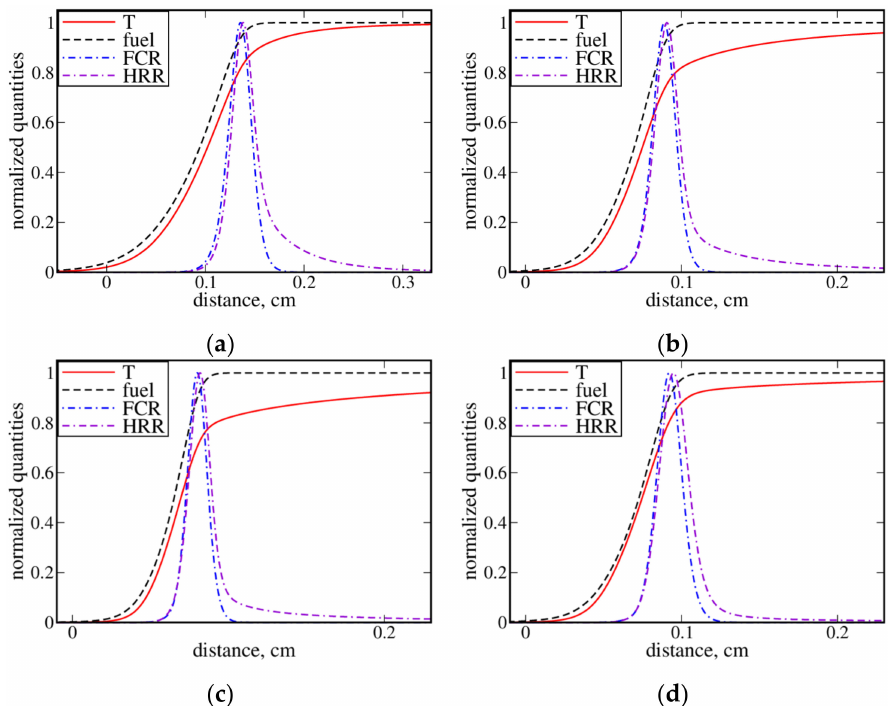
Figure 2. Profiles of c T , c F , fuel consumption rate, and heat release rate, normalized using their peak values. The profiles have been obtained from unperturbed methane–air premixed flames characterized by different equivalence ratios: ( a ) φ = 0.6, ( b ) φ = 0.8, ( c ) φ = 1.0, and ( d ) φ = 1.25.